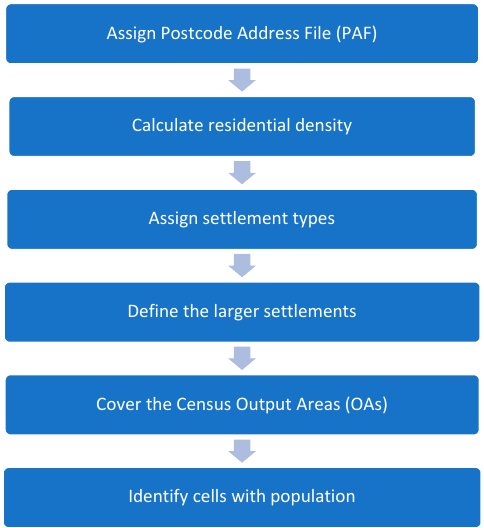
Figure 1. Steps in the identification of settlements [25] In Figure 2, sparseness represents the local density, and both rural and urban areas have been generally split into two parts. Each part still contains three settlement types.